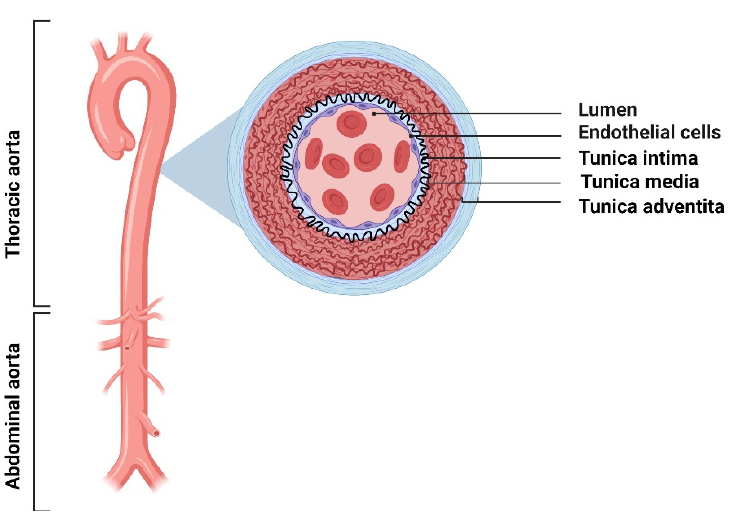
Figure 1. Structure of the layered wall of the human arterial vessel [21–26]. Tunica intima contains flattened ECs located on a lamina rich in collagen and elastin fibers. The subendothelial layer is part of the supporting tissue composed of myoid cells involved in synthesizing ECM components, i.e., proteoglycans, glycoproteins, and microfiber. Myoid cell layers store lipid substances, which causes thickening of the